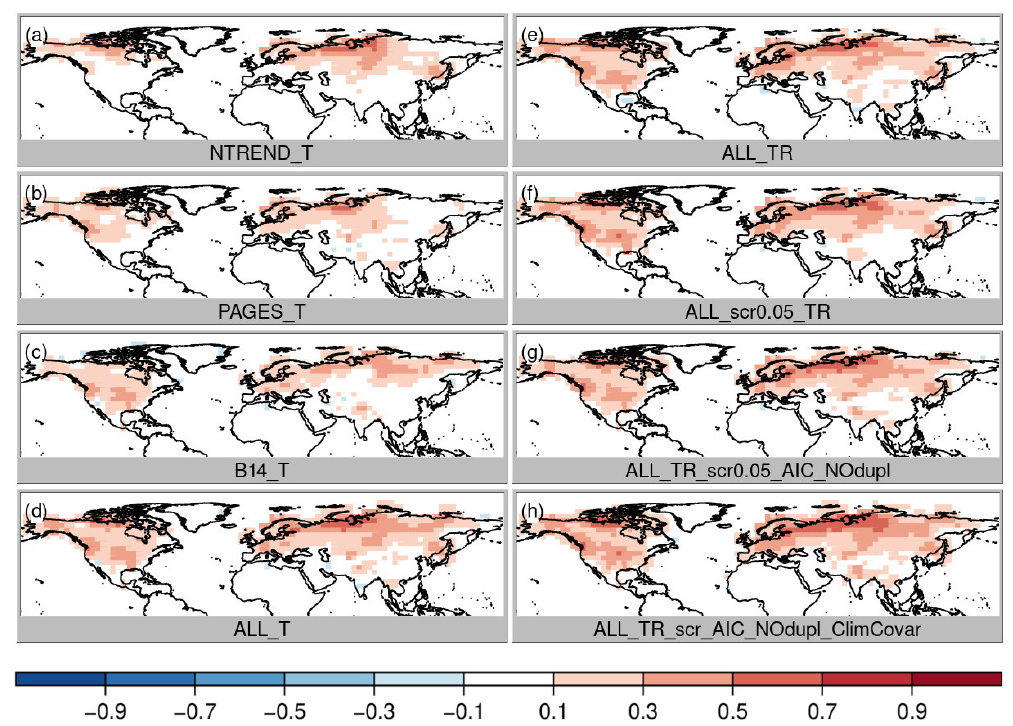
Figure 3. Temperature correlation improvement of the analysis over the original model simulations, i.e., correlation between analysis and CRU TS minus correlation between simulations and CRU TS, where red colors indicate an improvement of the analysis. All maps show the April to September growing season of the Northern